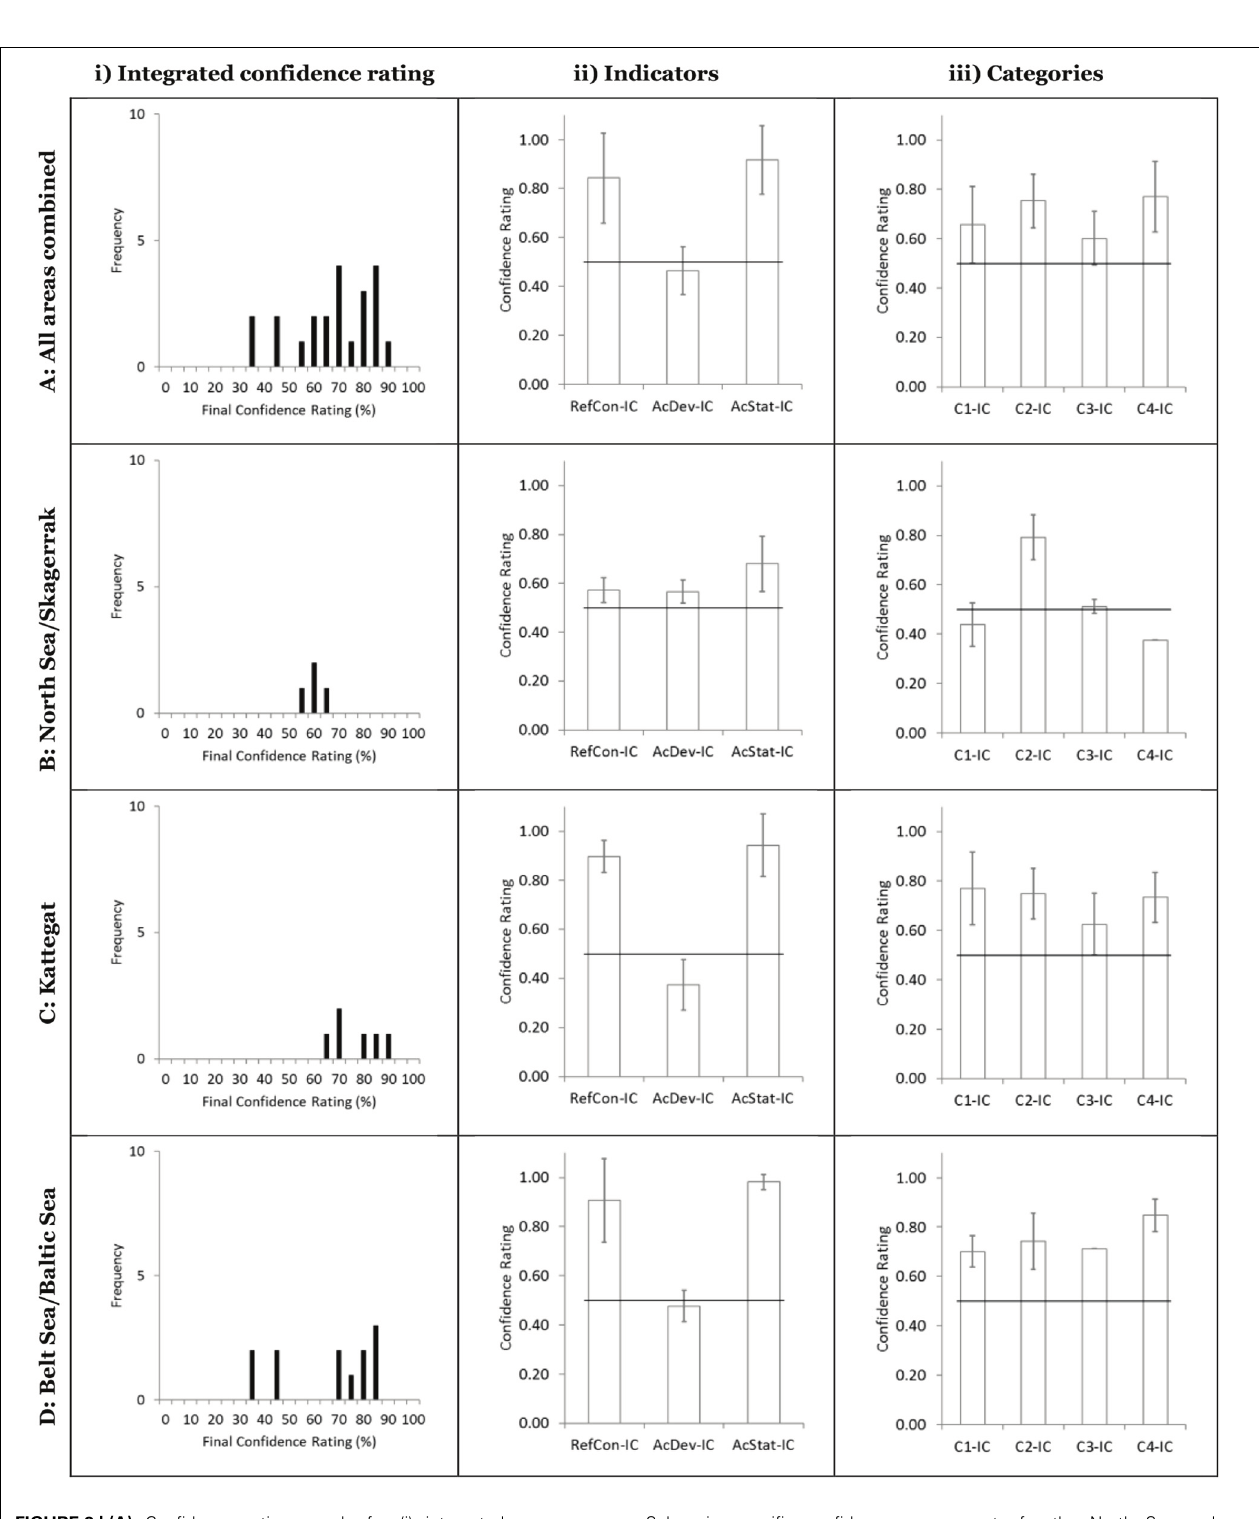
Sub-region-specific confidence assessments for the North Sea and Skagerrak, the Kattegat including the northern parts of the Sound and the Belt Sea and the western Baltic Sea. Please confer with Supplementary Material for